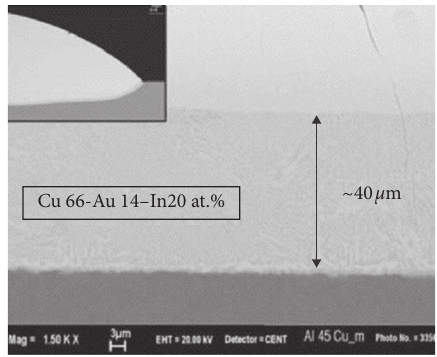
Figure 14: SEM micrographs of the cross section of the Au-In solder alloy on a pure Cu substrate